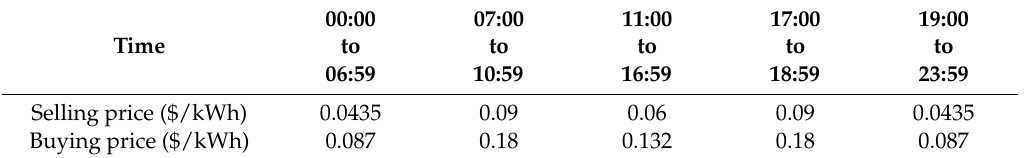
Table 2. Daily electricity